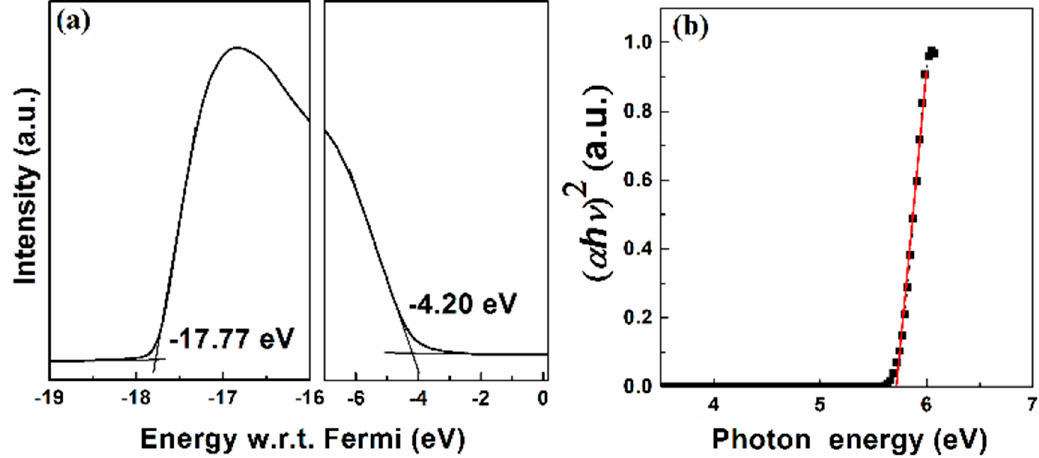
Figure 1. ( a ) Ultraviolet photoemission spectroscopy (UPS) spectra of as-prepared ZrIPO film. ( left panel) the secondary edge at high binding energy region, related to work function, ( right panel) the low-energy region, related to valence band maximum; ( b ) Determination of the optical bandgap using Tauc-plot for ZrIPO film.